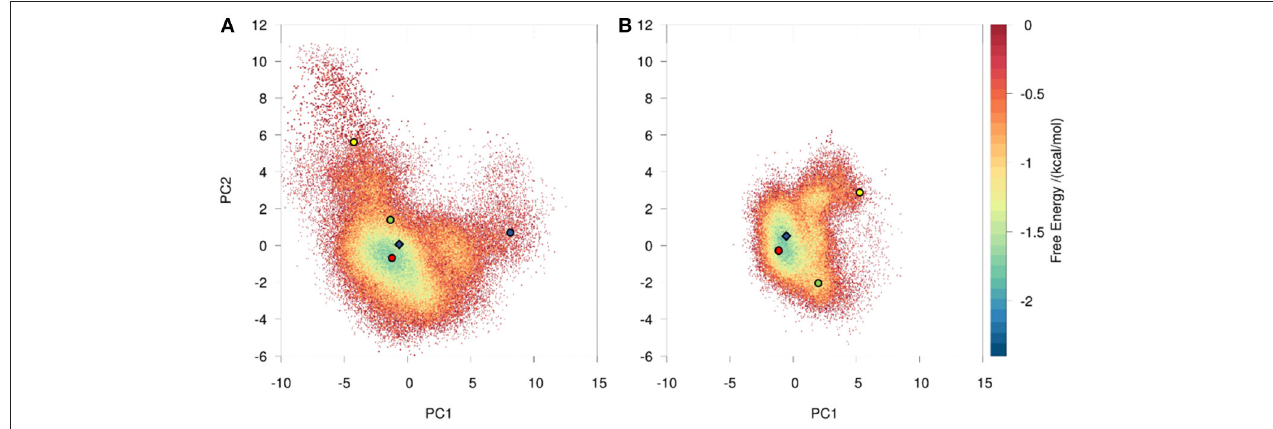
FIGURE 3 | Conformational space of the 6C8 antibody (A) and the further matured 8B10 (B) antibody with the projection of the crystal structures as diamonds. The variances for the PC1 and PC2 are 55 and 14% respectively. The trajectories are projected onto the combined PCA space, illustrating the differences in conformational diversity. The PCCA + cluster representatives are illustrated as circles color-coded according to the Markov-state model in Figure 4 .